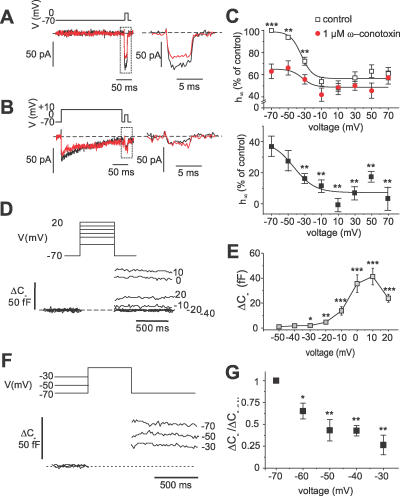
Voltage-Dependent Inactivation of α-Cell N-Type Ca2+ Currents and Exocytosis(A) N-type Ca2+ currents were evaluated during blockade of the L-type channels with isradipine (2 μM). The N-type channel antagonist ω-conotoxin (1 μM; red traces) reduced the Ca2+ current elicited by a step depolarisation from −70 to 0 mV (right).(B) As in (A), but the pulse to 0 mV was preceded by a 200-ms conditioning depolarization to +10 mV. ω-Conotoxin was without effect on the current measured during the depolarization to 0 mV under these conditions (right).(C) Top: peak Ca2+ currents measured in the presence of 2 μM isradipine alone (open squares) or together with 1 μM ω-conotoxin (red circles) during a depolarization to 0 mV following 200-ms conditioning pulses to between −70 and +70 mV. Lower: inactivation of the ω-conotoxin–sensitive component. Half-maximal inactivation of the N-type current was at −31 ± 6 mV (n = 5).(D) Exocytosis was elicited with 500-ms depolarisations from −70 mV to between −50 and 20 mV.(E) The voltage dependence of the exocytotic response.(F) Exocytosis elicited by 500-ms depolarisations to 0 mV from holding potentials of between −70 and −30 mV.(G) Summary of effects of holding potential on exocytotic responses elicited by depolarisations to 0 mV. Data have been normalized to responses obtained using a holding potential of −70 mV.*, p < 0.05; **, p < 0.01; ***, p < 0.001, compared with ω-conotoxin (C, top) or with the initial response.